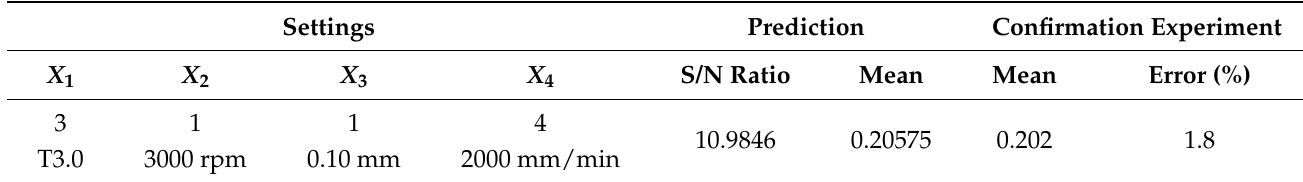
Table 7. Optimal forming settings from Taguchi method and confirmation